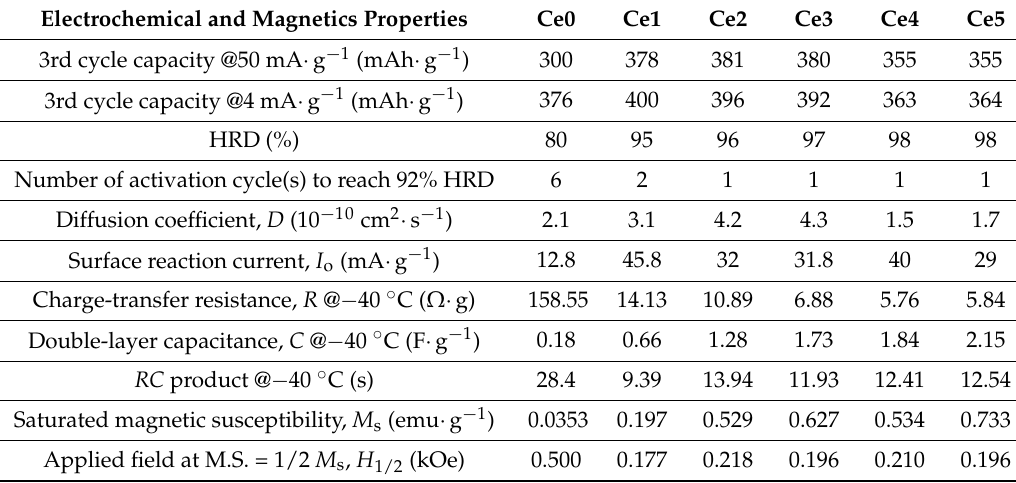
Figure 11. Evolutions of ( a ) low-rate capacity and ( b ) HRD at the third cycle with increasing RE- content in the design.